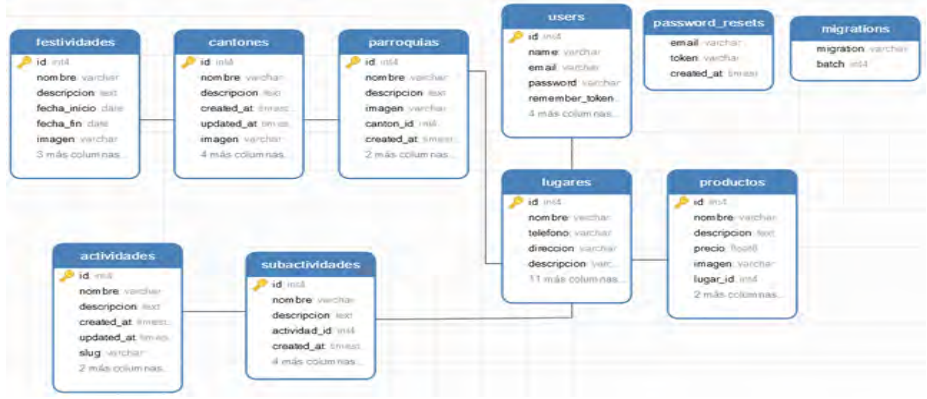
Figure 1 Exemplar design of data of a virtual